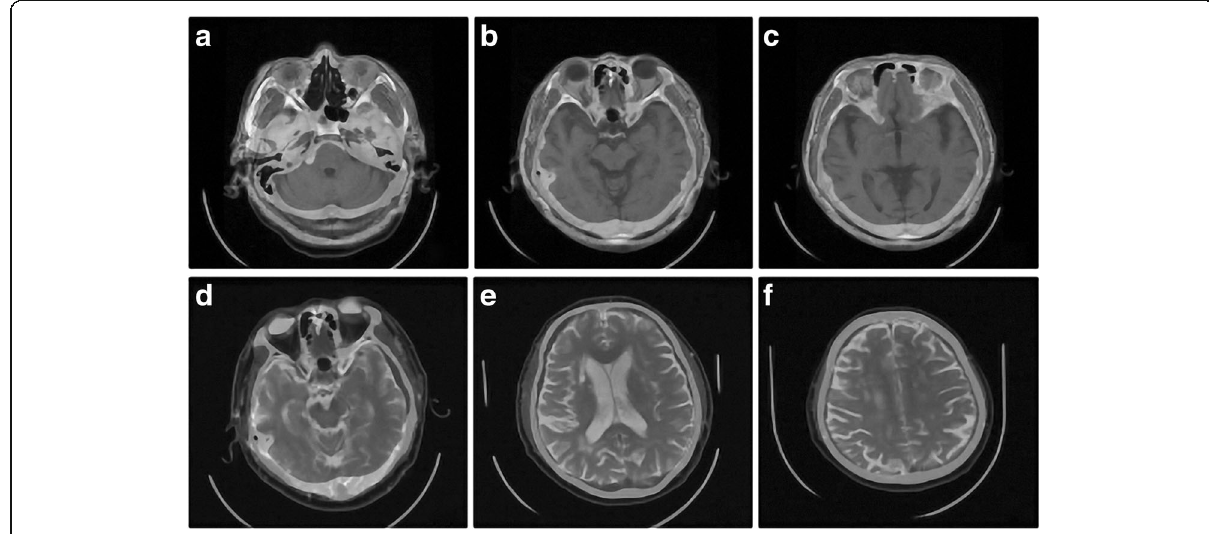
Fig. 13 The wavelet-weighted maximum fusion result of patient one. a , b , c are the fusion results of CT and T1-MRI, while d , f are the fusion results of CT and